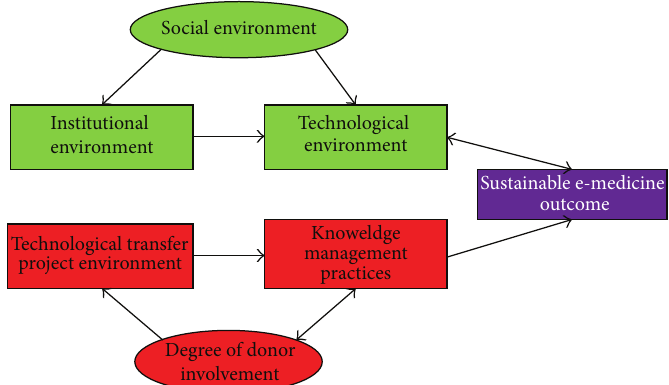
Figure 2: Framework for e-medicine